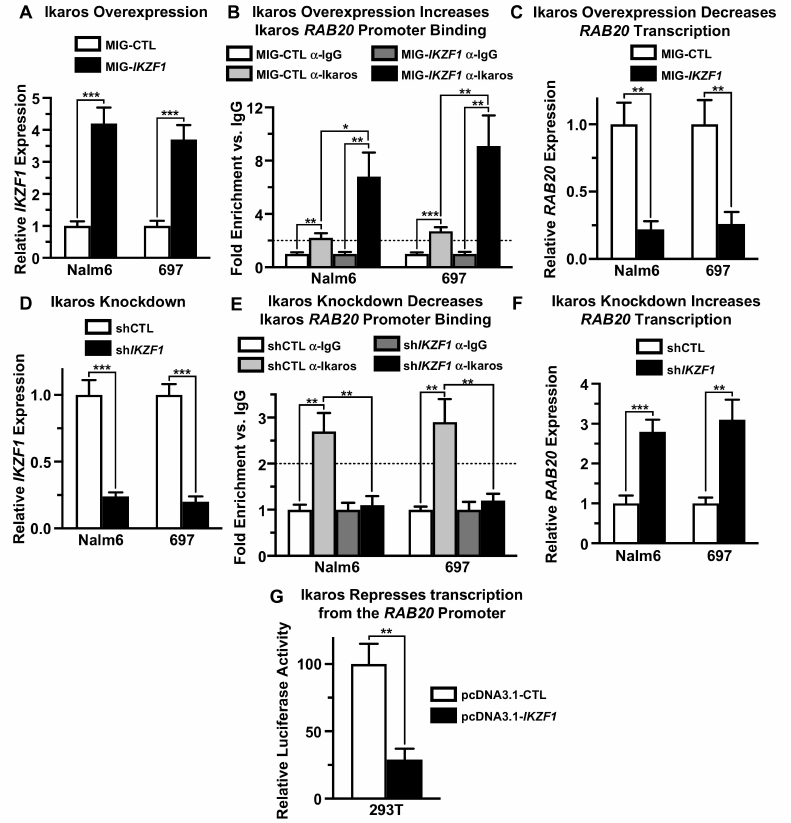
Figure 2. Ikaros represses RAB20 transcription. ( A ) Human B-ALL cell lines were transduced with empty vector (MIG-CTL) or Ikaros (MIG- IKZF1 ) and relative IKZF1 expression was determined by qRT-PCR. ( B ) qChIP was used to determine Ikaros occupancy at the RAB20 promoter after Ikaros overexpression. ( C ) Ikaros overexpression resulted in a decrease in RAB20 expression as determined by qRT-PCR. ( D ) Human B-ALL cell lines were transduced with scrambled shRNA (shCTL) and shRNA targeting IKZF1 (sh IKZF1 ) and relative Ikaros expression determined using qRT-PCR. ( E ) qChIP was used to determine Ikaros occupancy at the RAB20 promoter after Ikaros knockdown. ( F ) Ikaros knockdown resulted in an increase in RAB20 expression as determined by qRT-PCR. ( G ) The e ff ect of Ikaros on transcription from the URE of human RAB20 using a luciferase reporter assay following transfection with control vector (pcDNA3.1-CTL) or human Ikaros (pcDNA3.1- IKZF1 ). The graphed data are the mean ± SD (error bars) from three independent